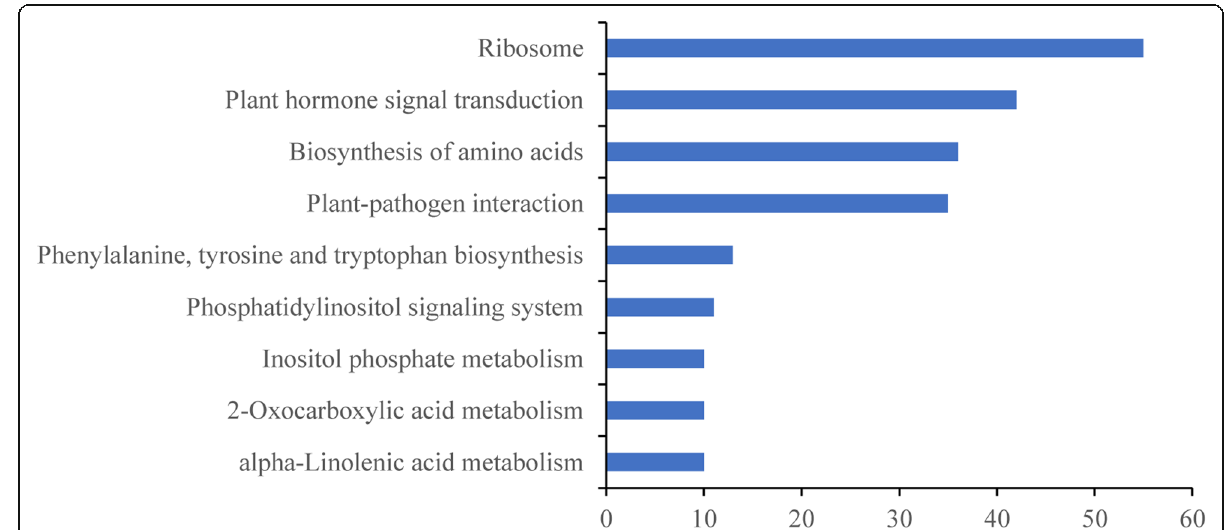
Fig. 8 Number of significantly upregulated DEGs for each category in the KEGG pathways. The number indicates the enriched upregulated DEGs in the nine KEGG